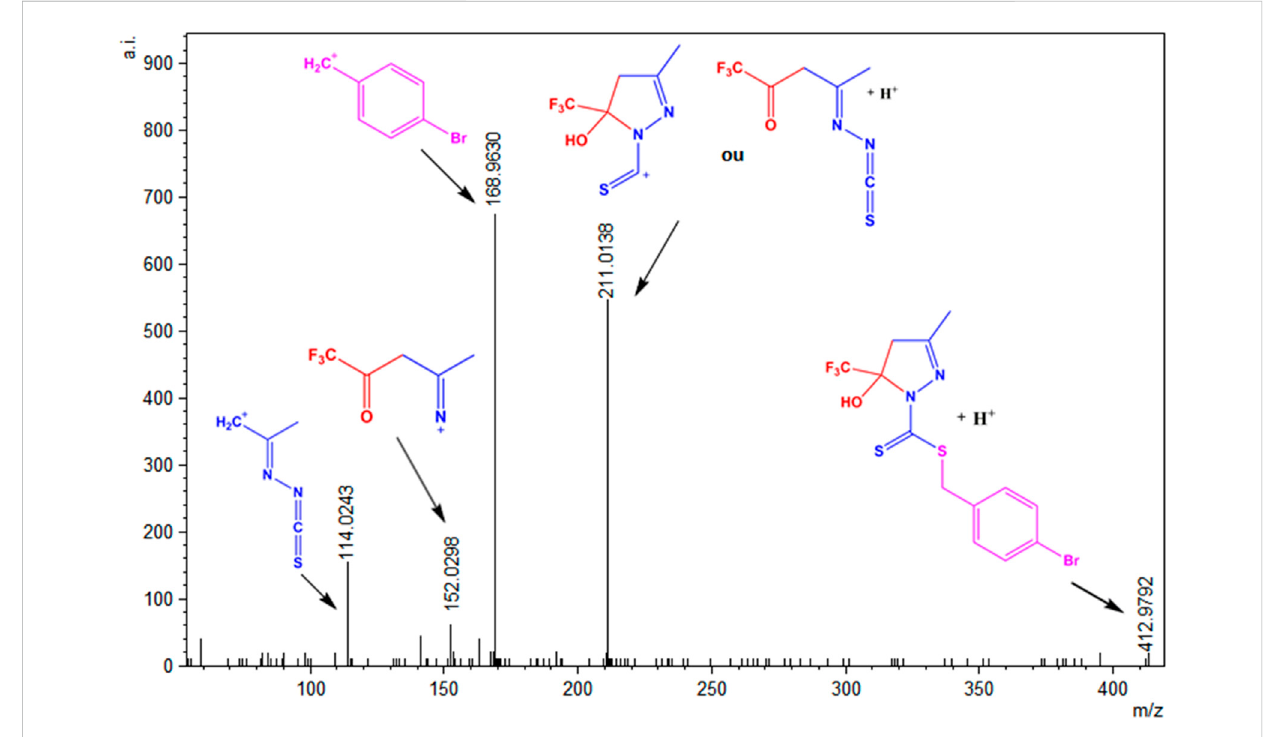
FIGURE 8 ESI(+)-MS/MS spectrum for H 2 L 1